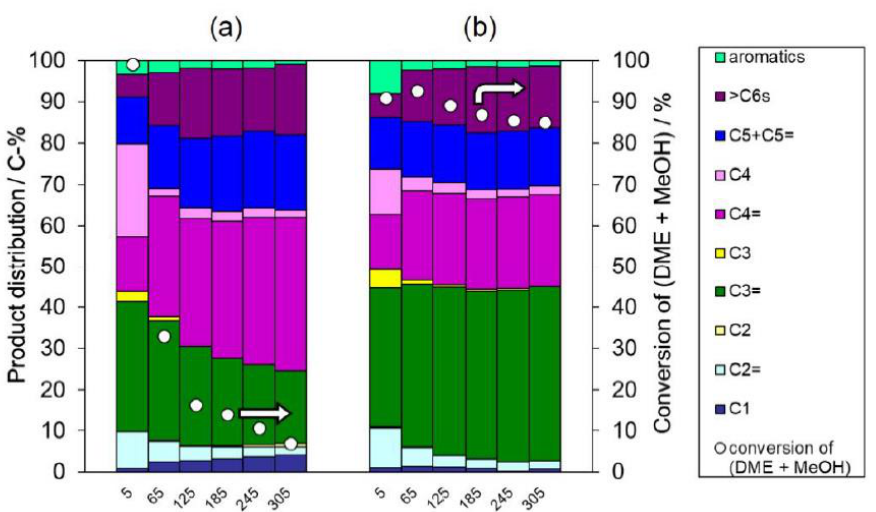
Figure 6. Results from the dimethyl ether (DME)-to-olefin (DTO) reaction over the ( a ) deAl-YFI-C(55) and ( b ) deAl-YFI-B(57). Pretreatment conditions: 550 ◦ C, 1 h under an air flow of 40 cm 3 (NTP) min − 1 . Reaction conditions: catalyst weight, 100 mg; W / F = 20 g-cat h mol − 1 ; pellet size, 500–600 µ m; He flow rate, 40 cm 3 (NTP) · min − 1 ; temperature, 400 ◦ C. As explained in Section 2.4, the dealuminated versions of YFI-A, B, C, and D are referred to herein as deAl-YFI-A, B, C, and D( n ), respectively, where n indicates the Si/Al ratio. Coke amounts in the spent catalysts estimated by thermogravimetric analyses were ( a ) 91 and ( b ) 105 mg (g-cat) −1 .